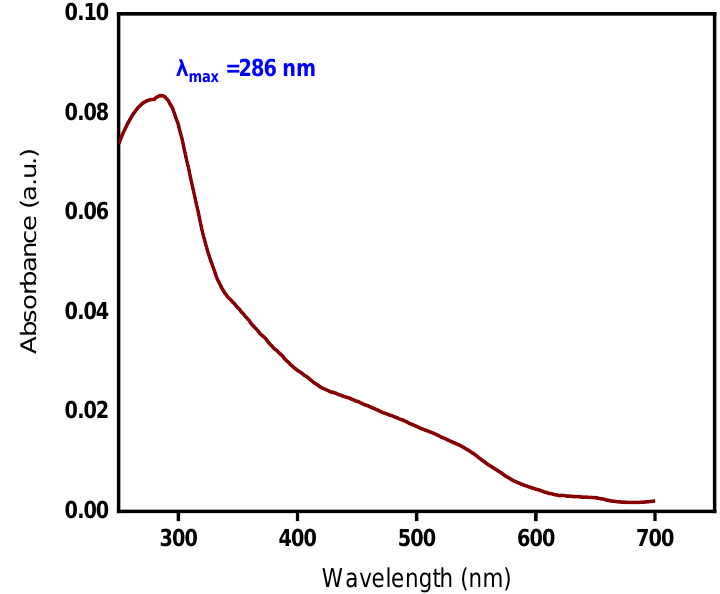
Figure 1. UV-Vis Spectrum of CuO nanoplates.